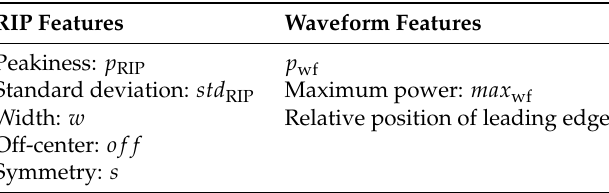
Table 1. Features used for the